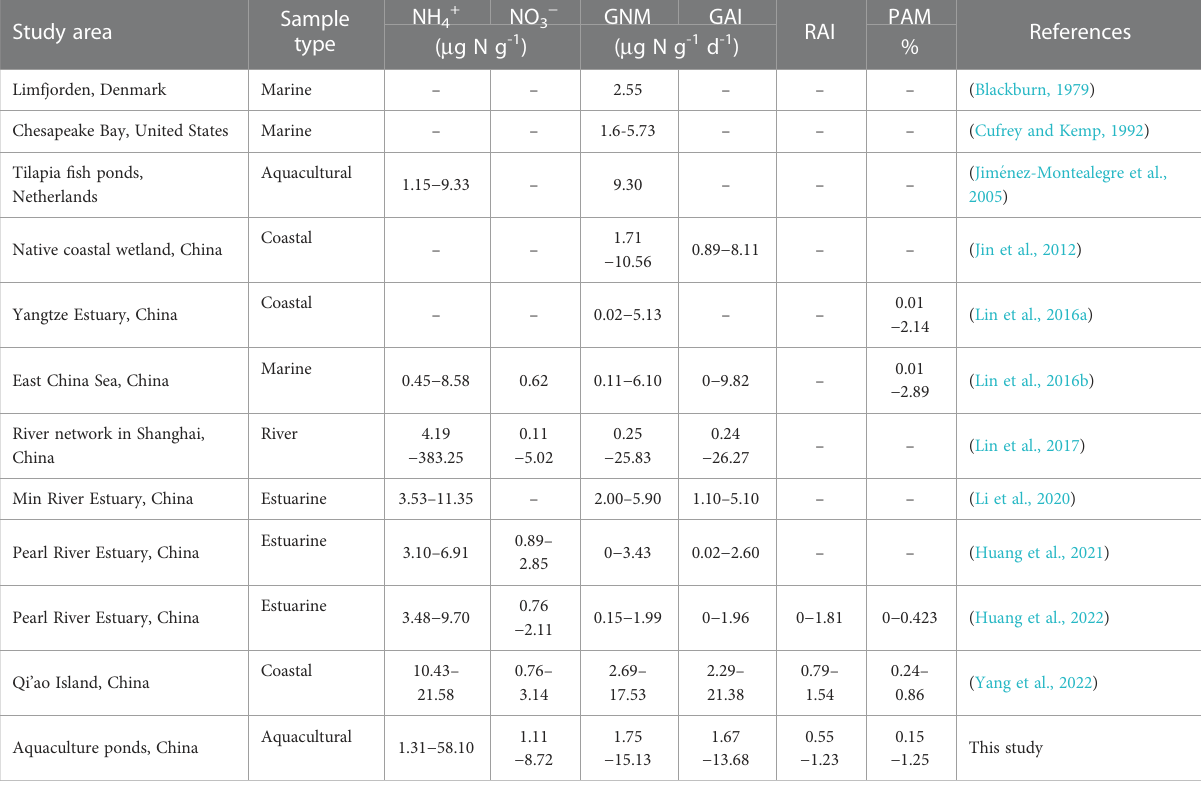
TABLE 4 Comparison of N mineralization and immobilization in coastal, estuarine, and aquacultural ecosystems and our study area.